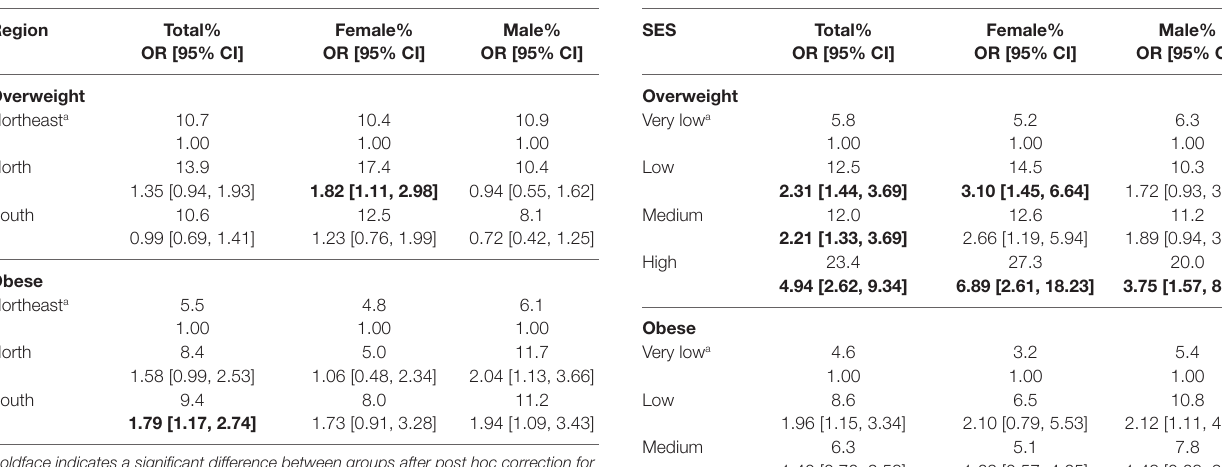
TaBle 3 | Comparison of overweight and obesity prevalence by SES strata within gender-specific and aggregated groups.